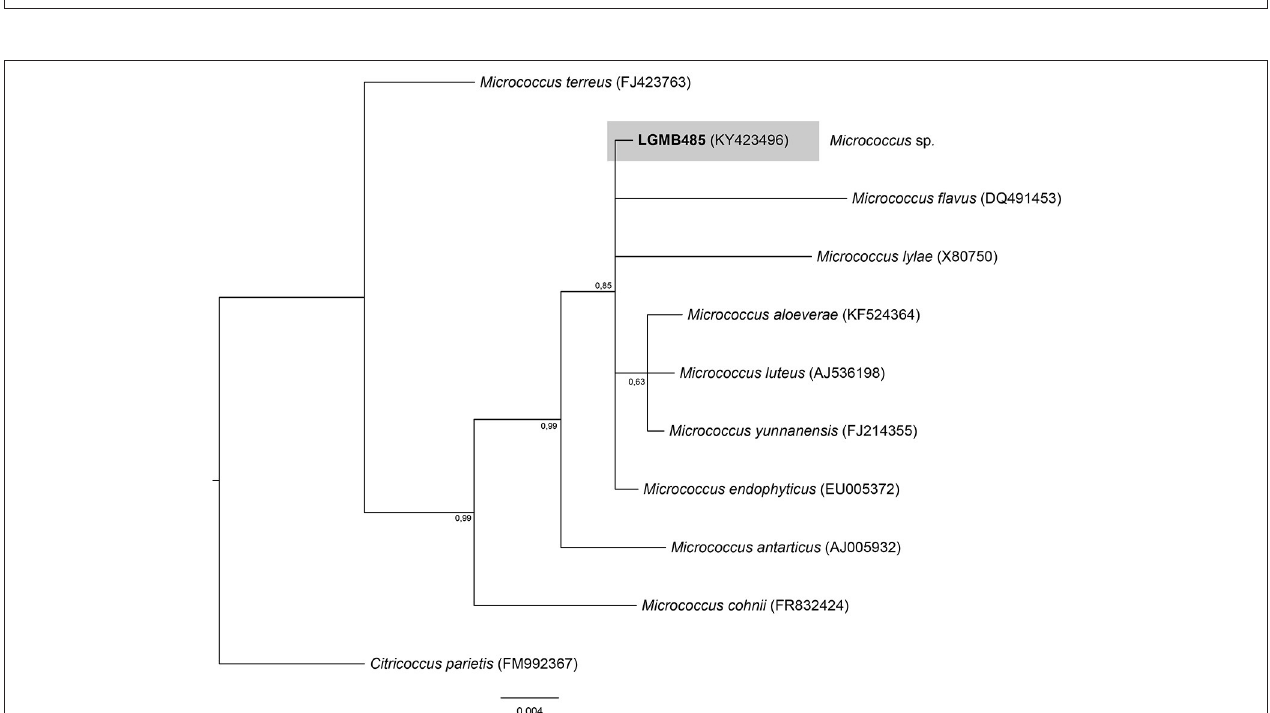
FIGURE 5 | Bayesian phylogenic tree based on 16S rRNA gene of LGMB485 and the 9 type strain of Micrococcus genus. Values on the node indicate Bayesian posterior probabilities. The species Citricoccus parietis was used as out group. Scale bar indicates the number of substitutions per site.